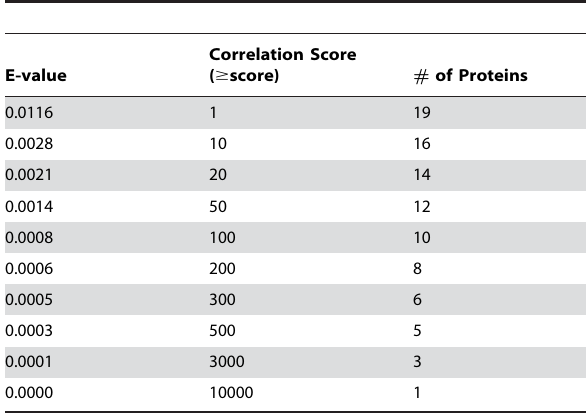
Table 3. Correlation analysis for proteins with known terms that differ from predicted ones